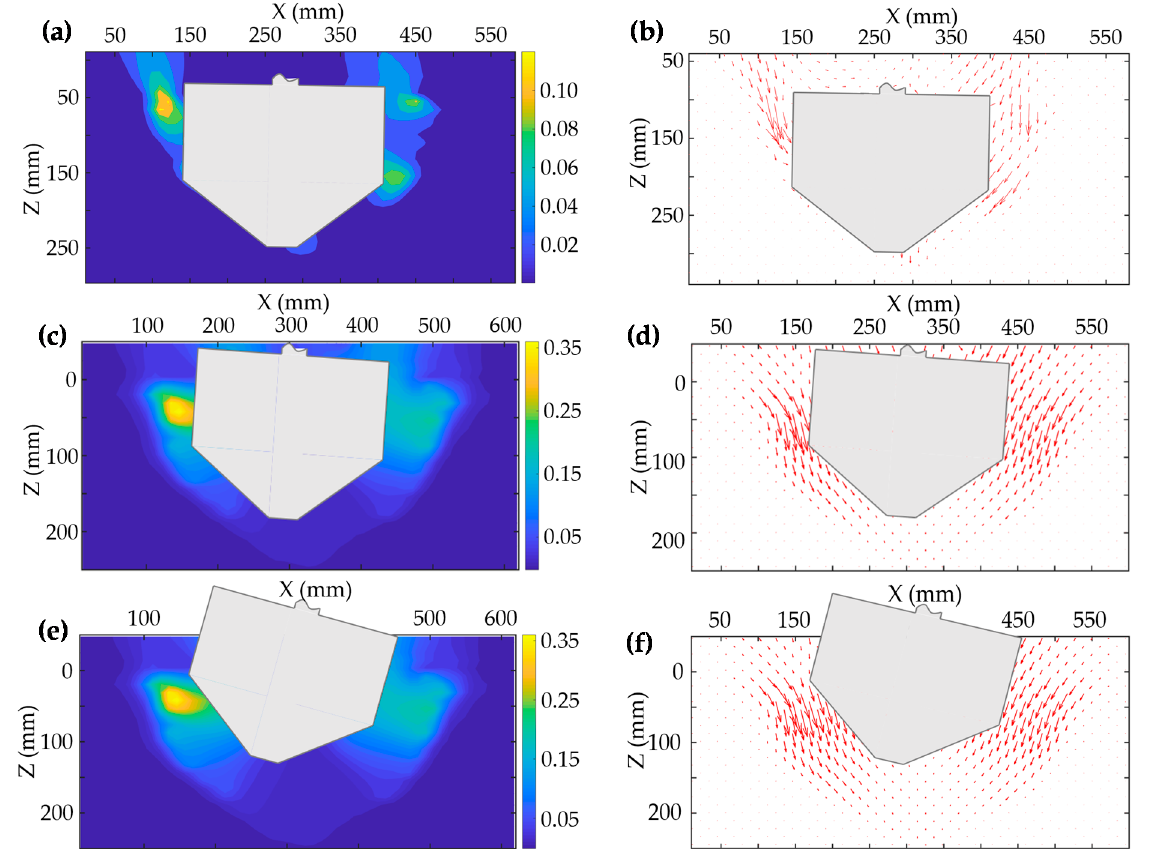
Figure 9. The displacement vector diagrams and displacement cloud diagrams of medium dense sands: ( a ) displacement cloud diagram in floating stage; ( b ) displacement vector diagram in floating stage; ( c ) displacement cloud diagram in inclined stage; ( d ) displacement vector diagram in inclined stage; ( e ) displacement cloud diagram in unstable failure stage; ( f ) displacement vector diagram in unstable failure stage.